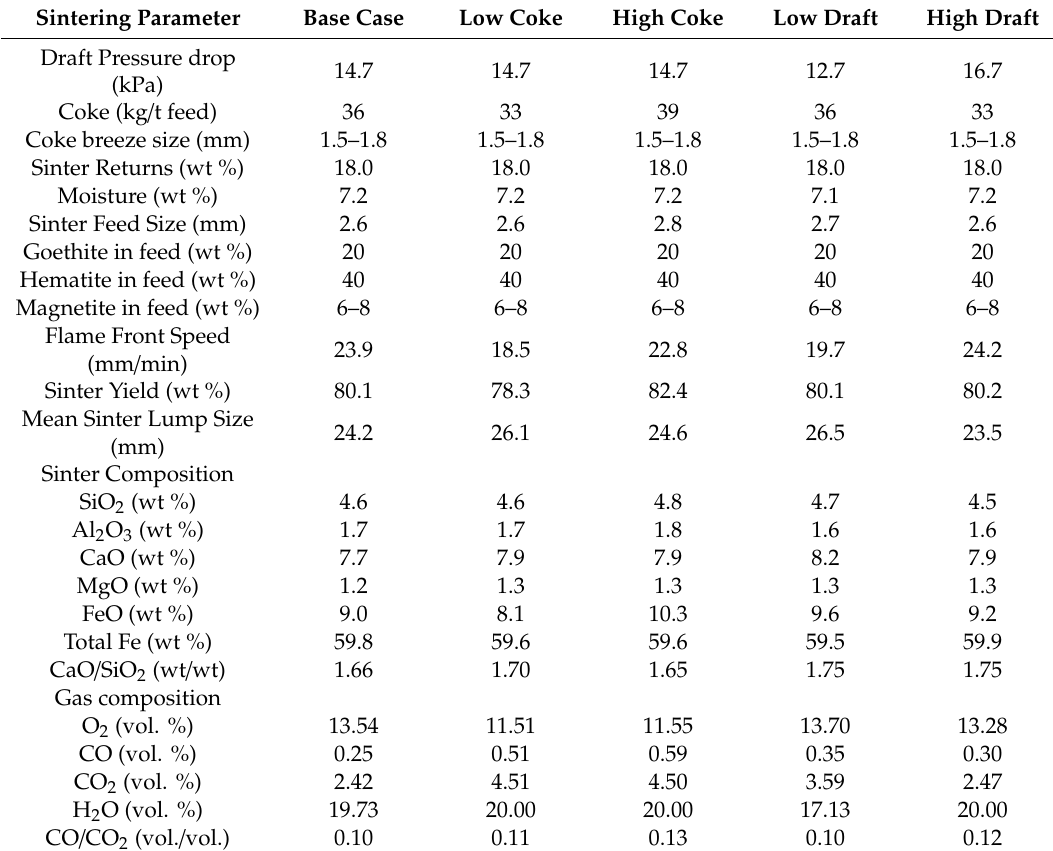
Table 1. Compositions of sinters (wt %) and process conditions